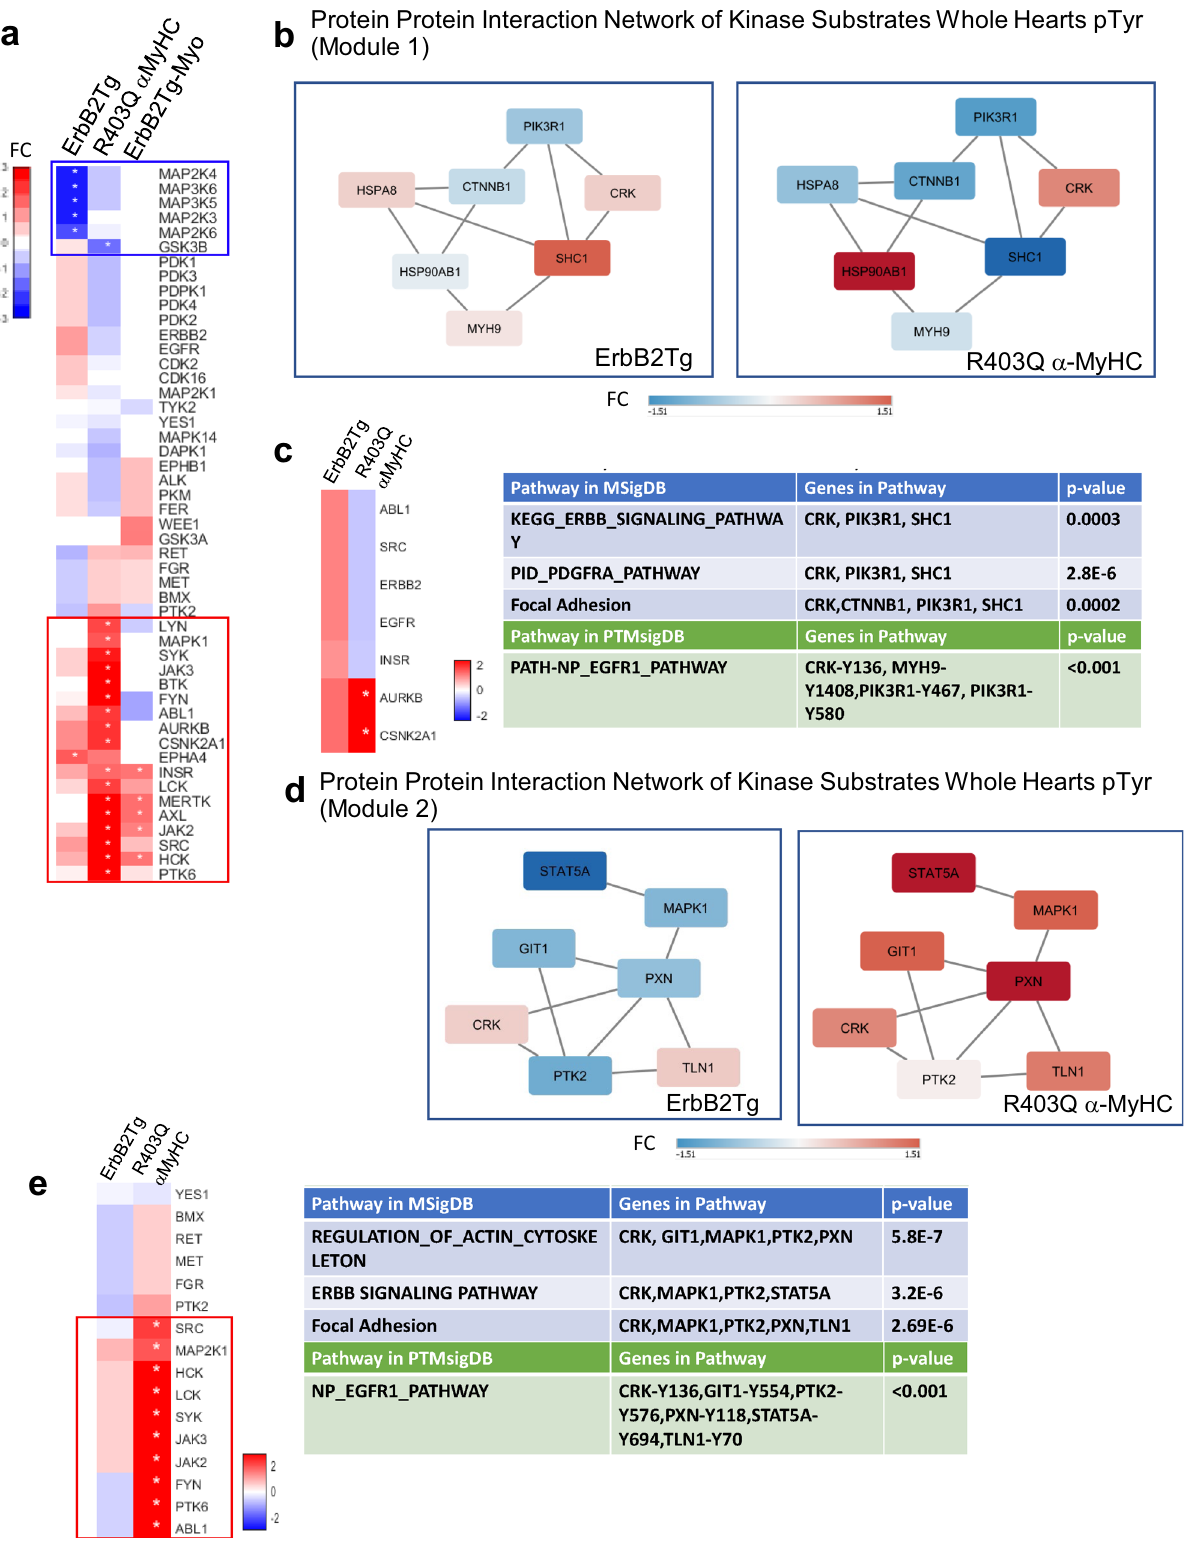
the impact of global dysregulated cardiac pTyr in the pathogen- esis of cardiac disease. Here, we show evidence that in TgErbB2 mice ’ s heart, tyrosine phosphoproteome is altered in a differential fashion, upregula- tion, and downregulation of tyrosine phosphopeptides. MsigDB pathway analysis demonstrated the involvement of ARVC,